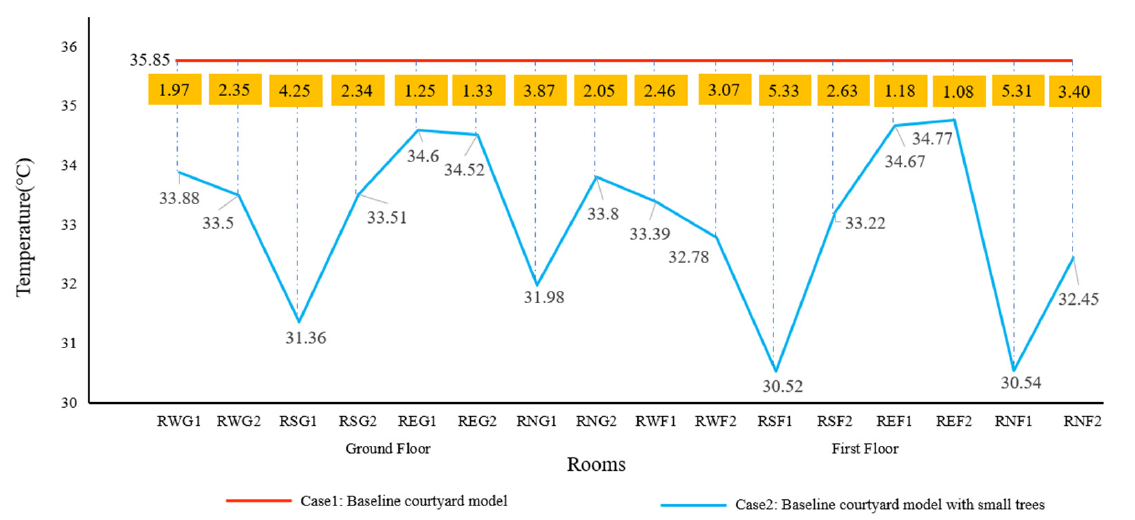
Figure 19. Comparison of air temperature for Case 1 and Case 2 in each room.